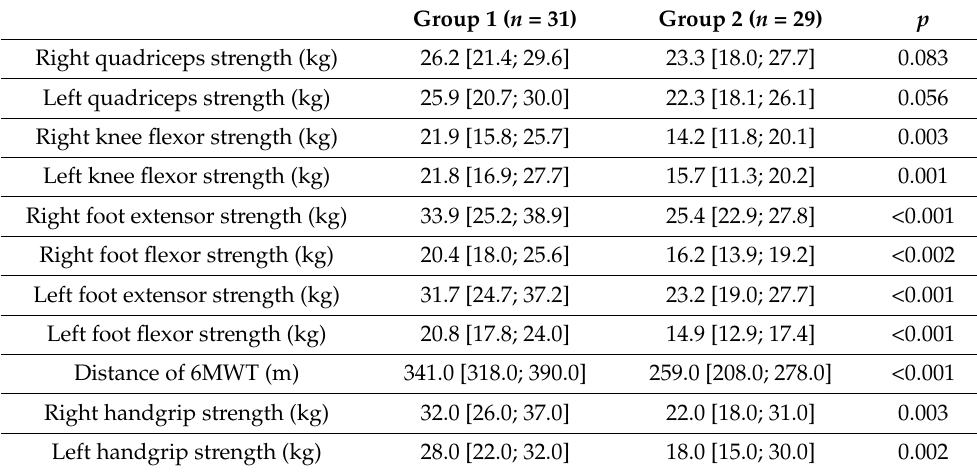
Table 3. Muscle status at discharge in groups.